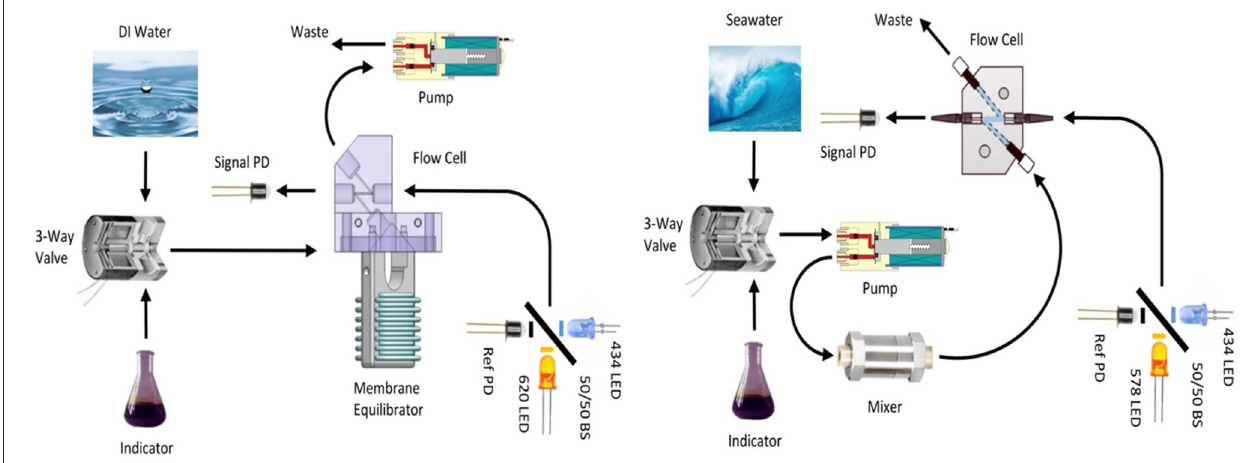
FIGURE 1 | Schematics of current design of (Left) SAMI-CO 2 and (Right) SAMI-pH. The SAMI-pH can be configured with an additional three-way valve at the seawater port to select between the seawater sample and a tris buffer certified reference material (CRM). 50/50 BS, 50% beam-splitter; Signal PD, Signal photodiode; Ref PD, reference